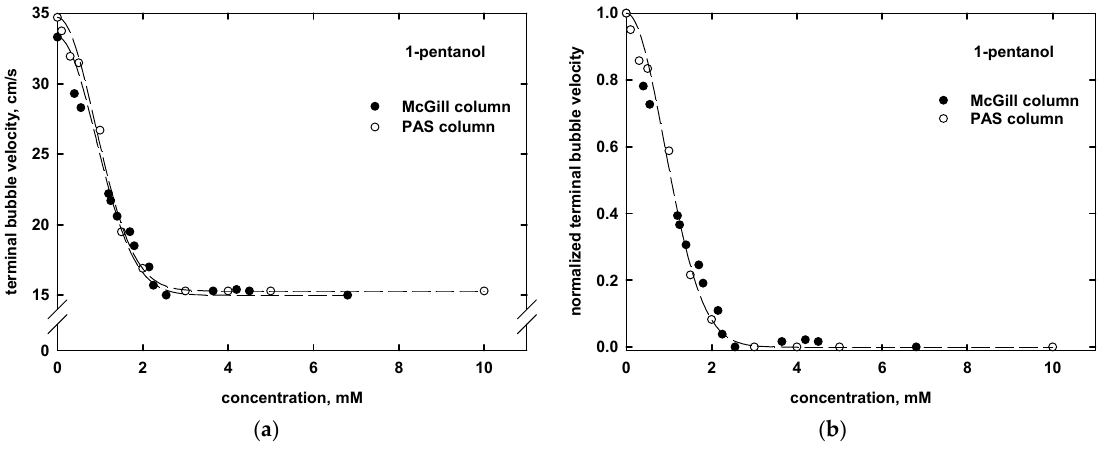
Figure 3. Influence of 1-pentanol concentration on ( a ) normal and ( b ) normalized ( v − v min )/( v max − v min ) terminal bubble velocity measured in McGill (300 cm) and PAS (30 cm) columns.